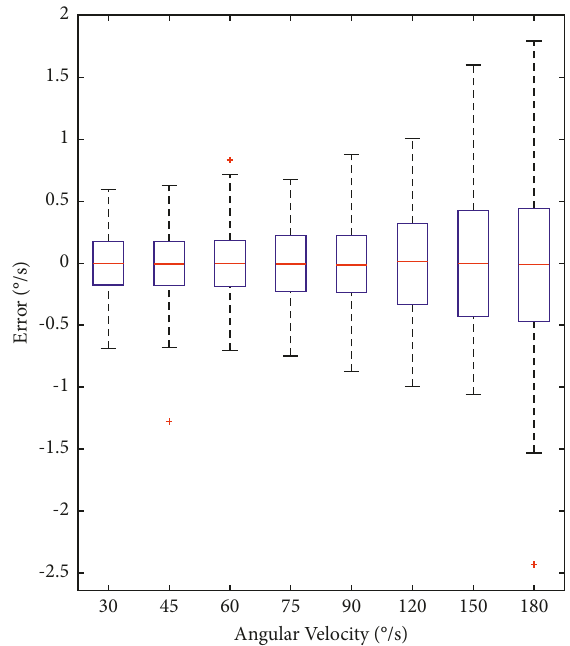
Figure 9: The statistics and distribution of errors between reference speed and PID controller speed response under various joint an- gular